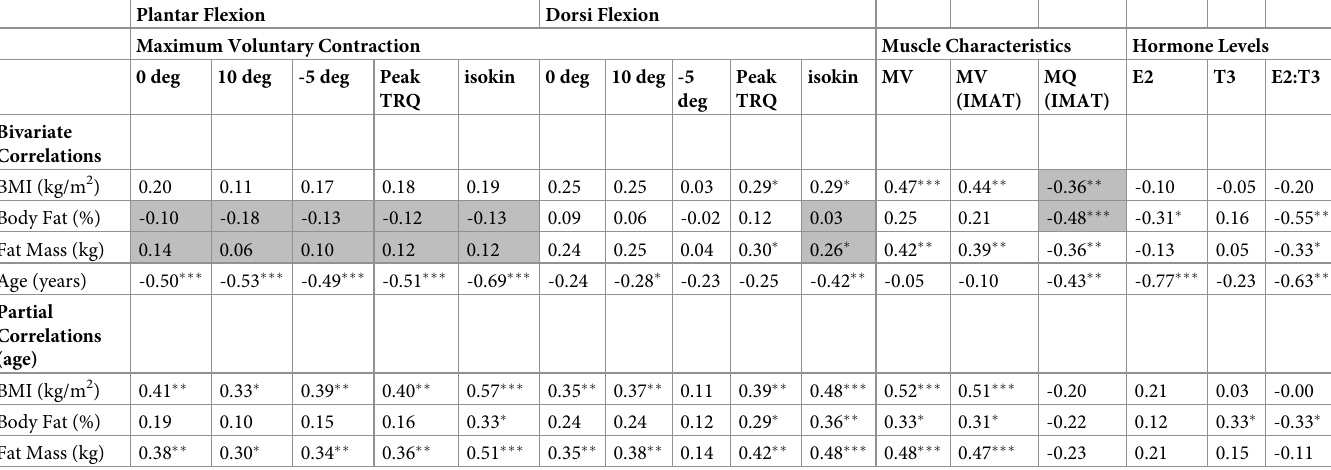
Significant correlations are highlighted by � p < 0.05 �� p < 0.01 ��� p < 0.001. Pearson correlations are highlighted in grey. Abbreviations: deg, degree; E2, Estradiol; isokin, isokinetic; MQ, muscle quality; MV, muscle volume; muscle volume corrected for intramuscular adipose tissue; MQ (IMAT), muscle quality corrected for intramuscular adipose tissue; Opt, optimum; T3, Tri-iodo-thyronine; TRQ, torque.